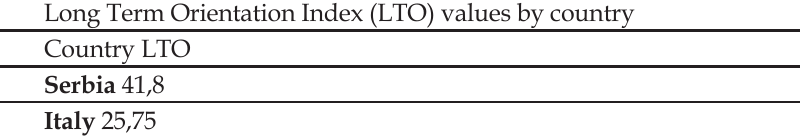
Table 6. Long Term Orientation Index (LTO) values by country. Long Term Orientation Index (LTO) values by